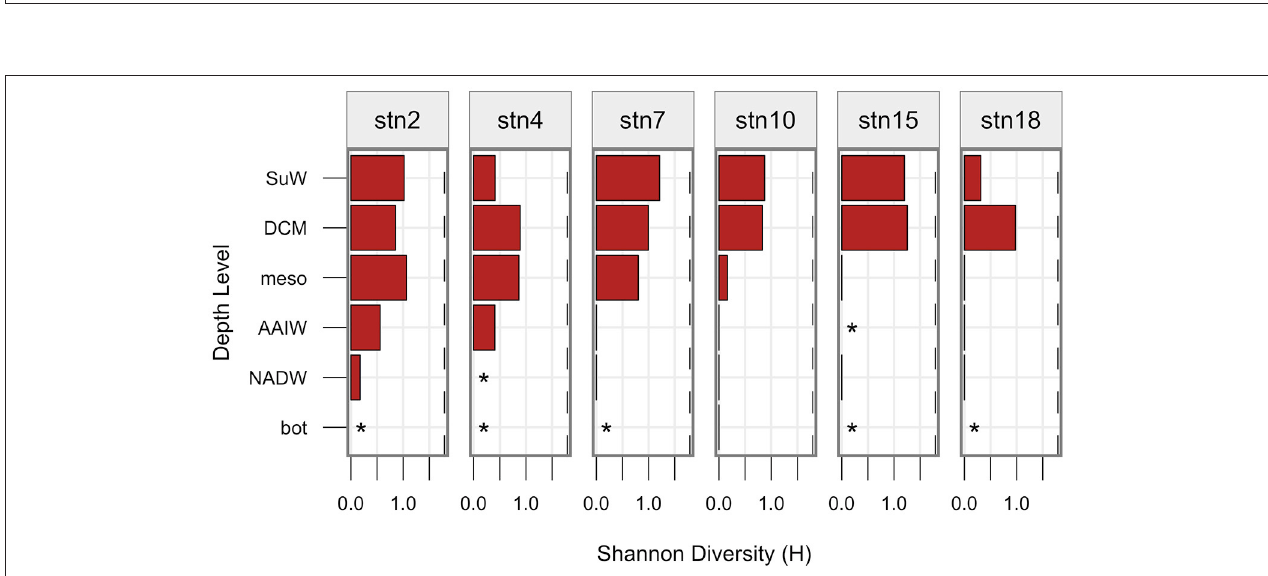
FIGURE 3 | Shannon diversity, H, at each station (vertical panels) and each depth surface to bottom (y axis). A shannon diversiy of zero is indicated by a straight line, whereas asterisks indicate H was not calculated due to no detectable hydrolysis at that site. The maximum possible value of H, 1.79, is shown as a dashed line.